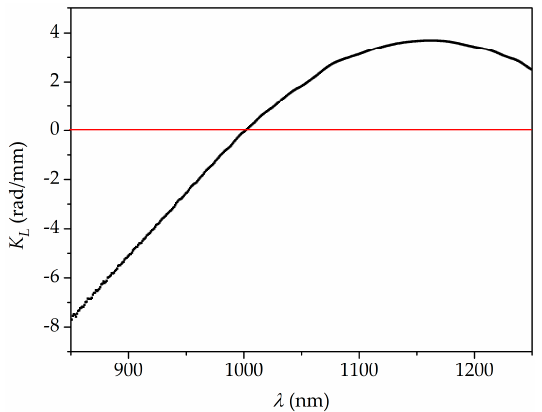
Figure 4. ( a ) Shift of the interference fringes around zero-sensitivity wavelengths upon TCF elongation; and ( b ) shift of the interference fringes upon temperature rise, shown in the same spectral range.